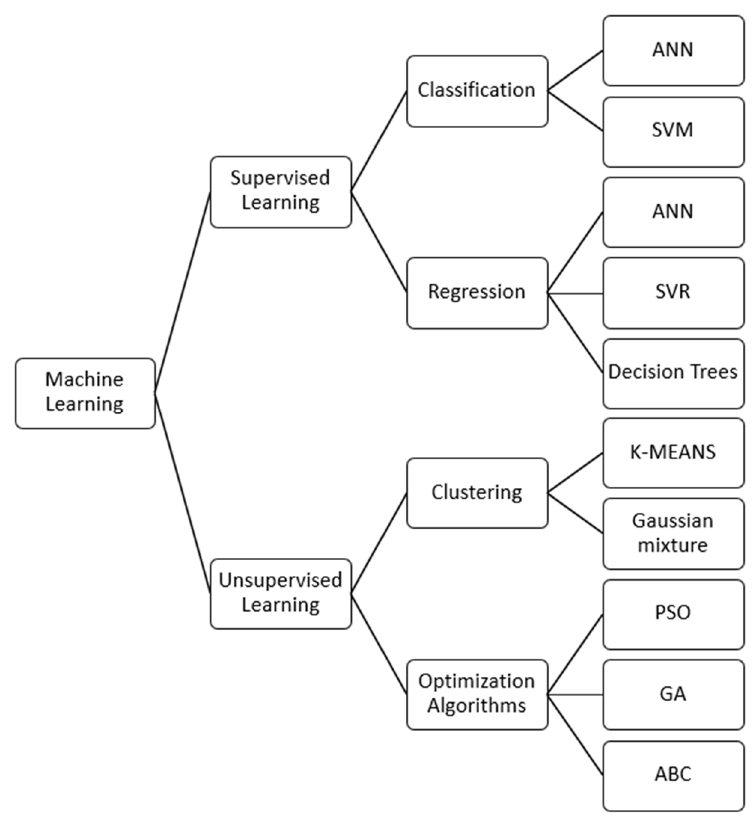
Figure 7. Machine learning classification, as adapted from [40].